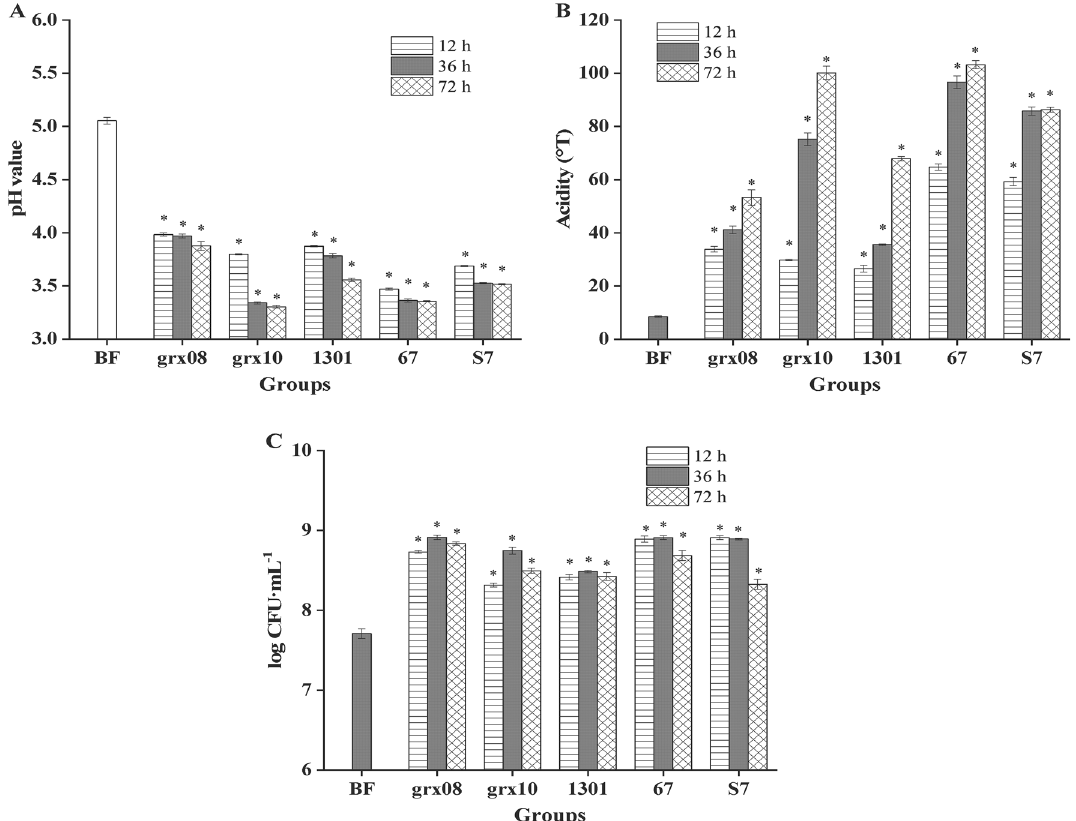
Fig. 1 Changes in pH ( A ), acidity ( B ) and viable bacteria count ( C ) of FH06 fermented by different LAB. * represents a significant difference compared with before fermentation (BF) ( P <